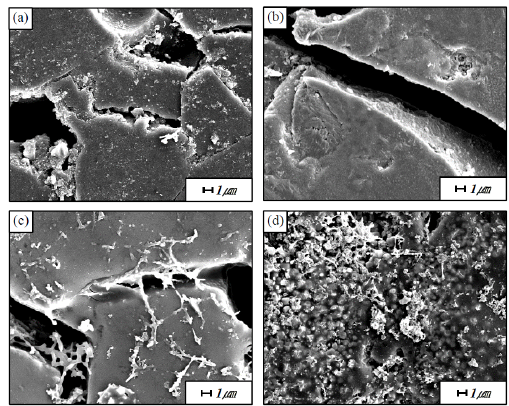
Figure 7. SEM micrographs showing the microstructure on the surface of the EBC after thermal shock test at 1350 °C: ( a ) mullite, 100 cycles; ( b ) mullite + Yb 2 SiO 5 , 100 cycles; ( c ) mullite, 5000 cycles; ( d ) mullite + Yb 2 SiO 5 , 5000 cycles.